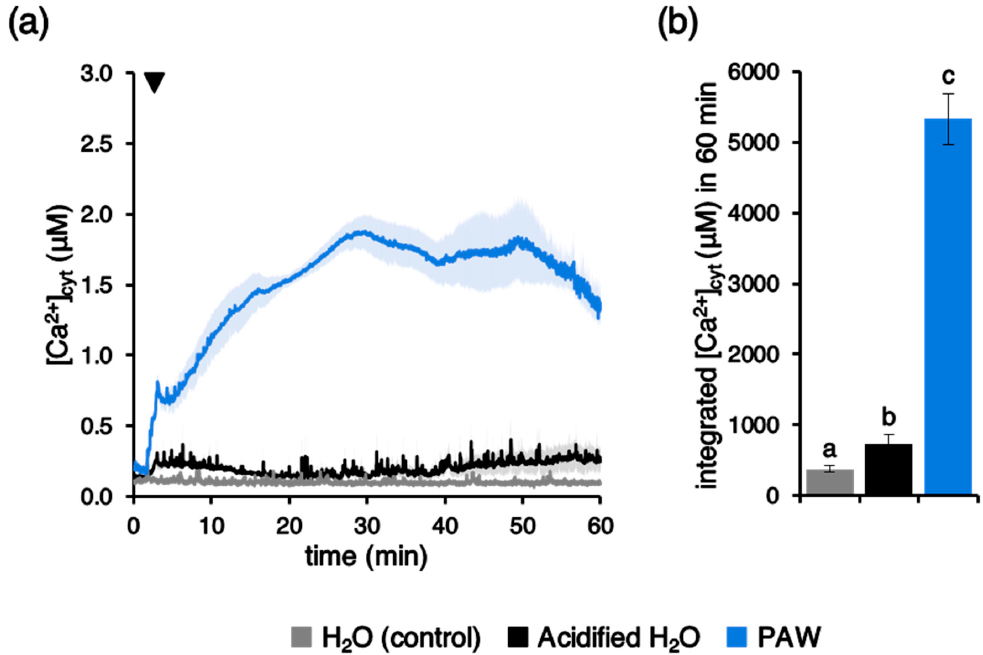
Figure 8. Comparison between the [Ca 2+ ] cyt responses induced by PAW and by an acidified H 2 O. Ca 2+ assays were conducted in aequorin-expressing Arabidopsis seedlings. Seedlings were challenged with 1:4 dilution of PAW generated by exposing deionized H 2 O to cold plasma for 5 min at 900 W torch #1 power (blue) or deionized H 2 O acidified to the same pH as PAW at 1:4 dilution (pH 3.5) (black). Untreated deionized H 2 O (pH 5.5) was administered to control samples (grey). ( a ) Data are the means (solid lines) ± SE (shading) of six different seedlings derived from three independent growth replicates. The arrowhead indicates the time of stimulus application (at 100 s). ( b ) Statistical analyses of integrated [Ca 2+ ] cyt dynamics over 60 min are shown. Bars labelled with different letters differ significantly ( p < 0.05, Student’s t test).